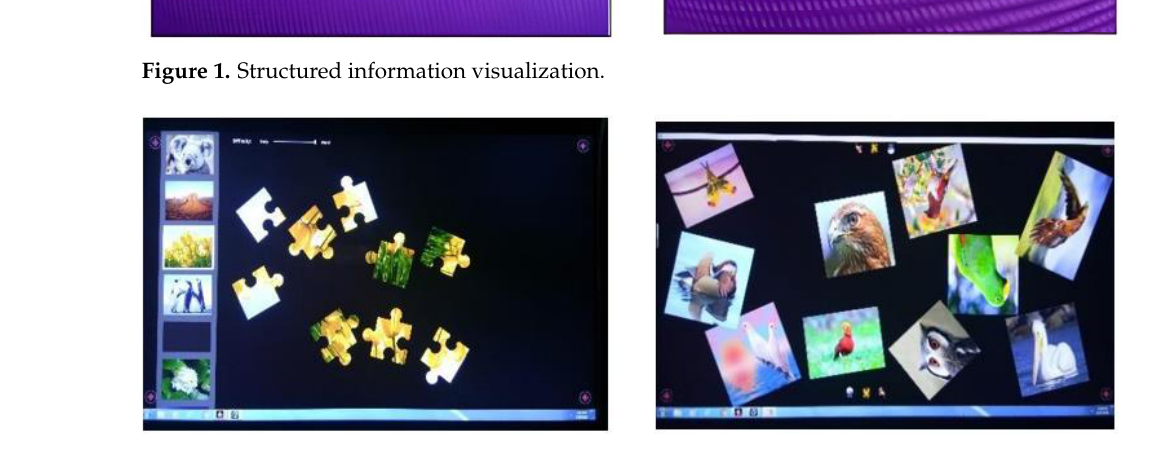
Figure 1. Structured information visualization.